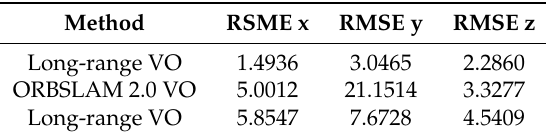
Figure 14. Comparison of long-range VO path and ORBSLAM 2.0 path in the altitude direction. ORBSLAM 2.0 fails at 400 seconds of the dataset. At this time, the MAV altitude increases sharply, so ORBSLAM 2.0 cannot deal with this long-range high-altitude case. Table 1. Comparisons of path RMSE